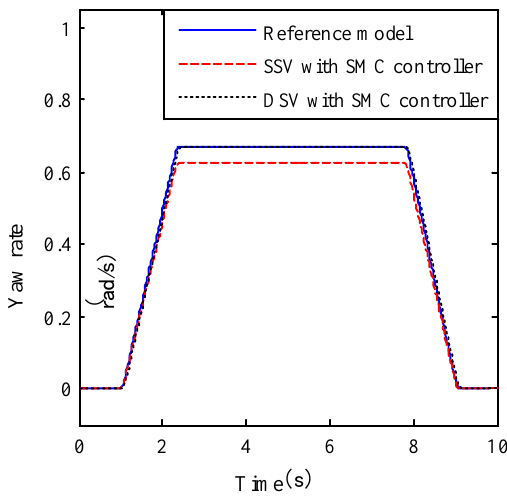
Figure 8. Yaw rate curves with k r 0 increased by 5%.